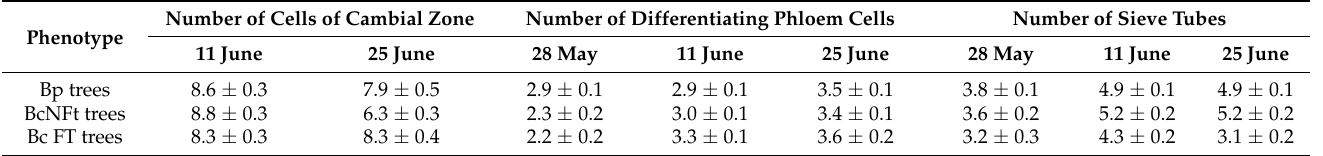
Table 1. The number of cells in the radial row: the cambial zone, the conducting phloem of B. pendula var. pendula (Bp), non-figured (NFt), and figured (Ft) B. pendula var. carelica trees. Samples